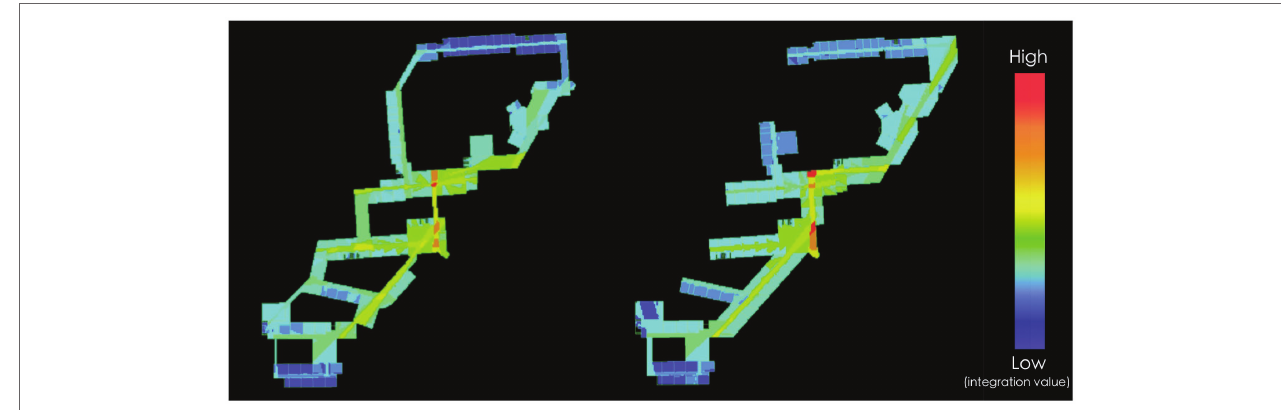
FIGURE 10 | Comparison of visibility graph analysis on local scale (integration, r = n ).